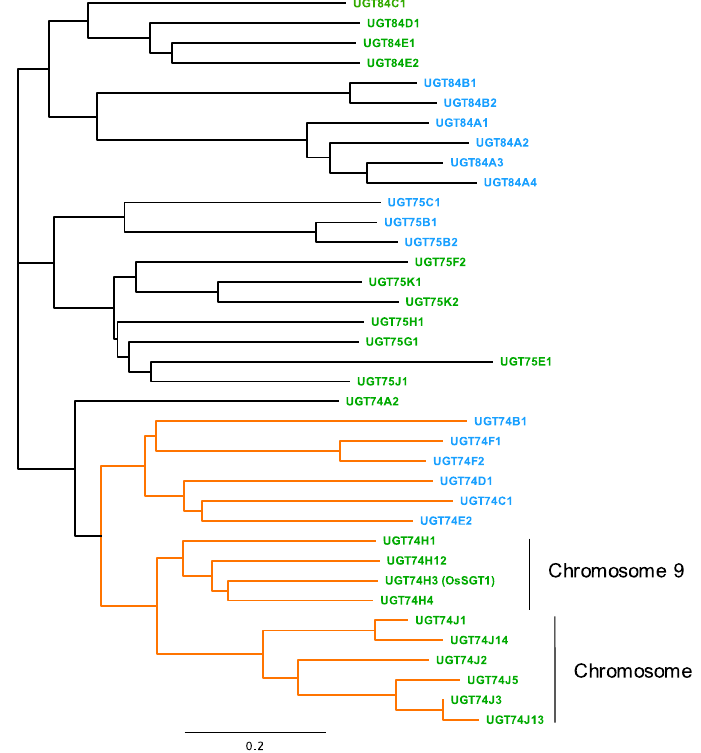
Figure 1. Phylogenetic analysis of UDP-glucosyltransferases in Arabidopsis and rice. The amino acid sequences of the UDP-glucosyltransferase family protein domain (accession: PLN02173) were aligned using ClustalW, and a phylogenetic tree was created using the neighbor-joining method. The bar represents the evolutionary distance between the proteins expressed as the number of substitutions per amino acid residue. Green and blue type indicate genes from rice and Arabidopsis UGTs, respectively. The clade including known SA-glucosyltransferase (UGT74F1, UGT74F2, and UGT74H3) is indicated by orange lines.